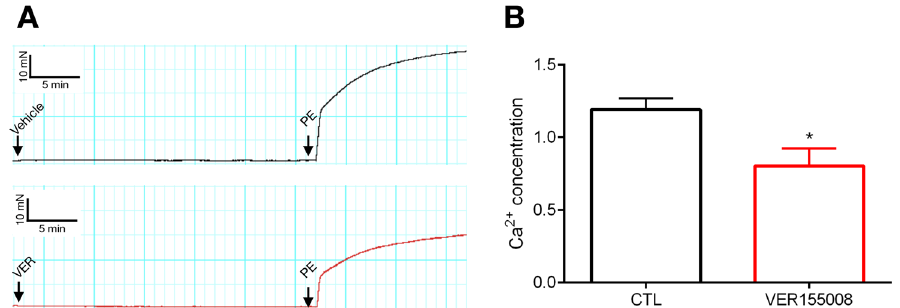
2 + Figure 1. HSP70 contributes to Ca handling in phenylephrine-stimulated aorta. ( A ) Representative force tracing (time vs. force) for samples incubated with vehicle (CTL) or VER1550008 ( 10 µ mol/l ) for 30 min and challenged with phenylephrine ( 10 µ mol/l ) for 15 min. ( B ) The total concentration of free Ca with a commercially available kit (Abcam, ab102505). Data are expressed as mean ± SEM. n = 5–6, * p < 0.05 vs.